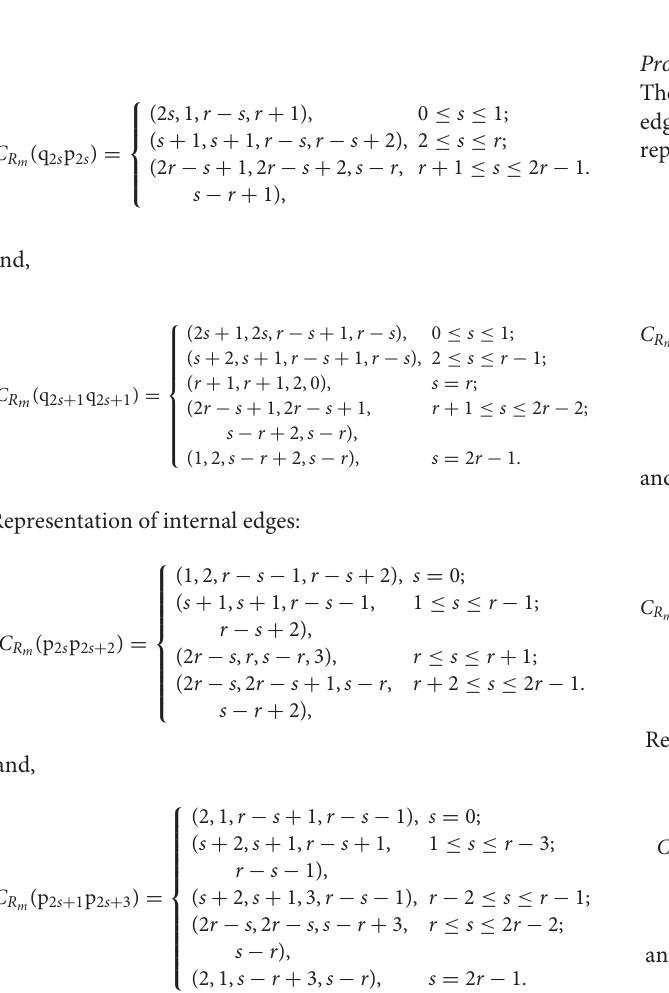
FIGURE 2 | (A) The generalized Petersen graph P (5,2), (B) The generalized Petersen graph P